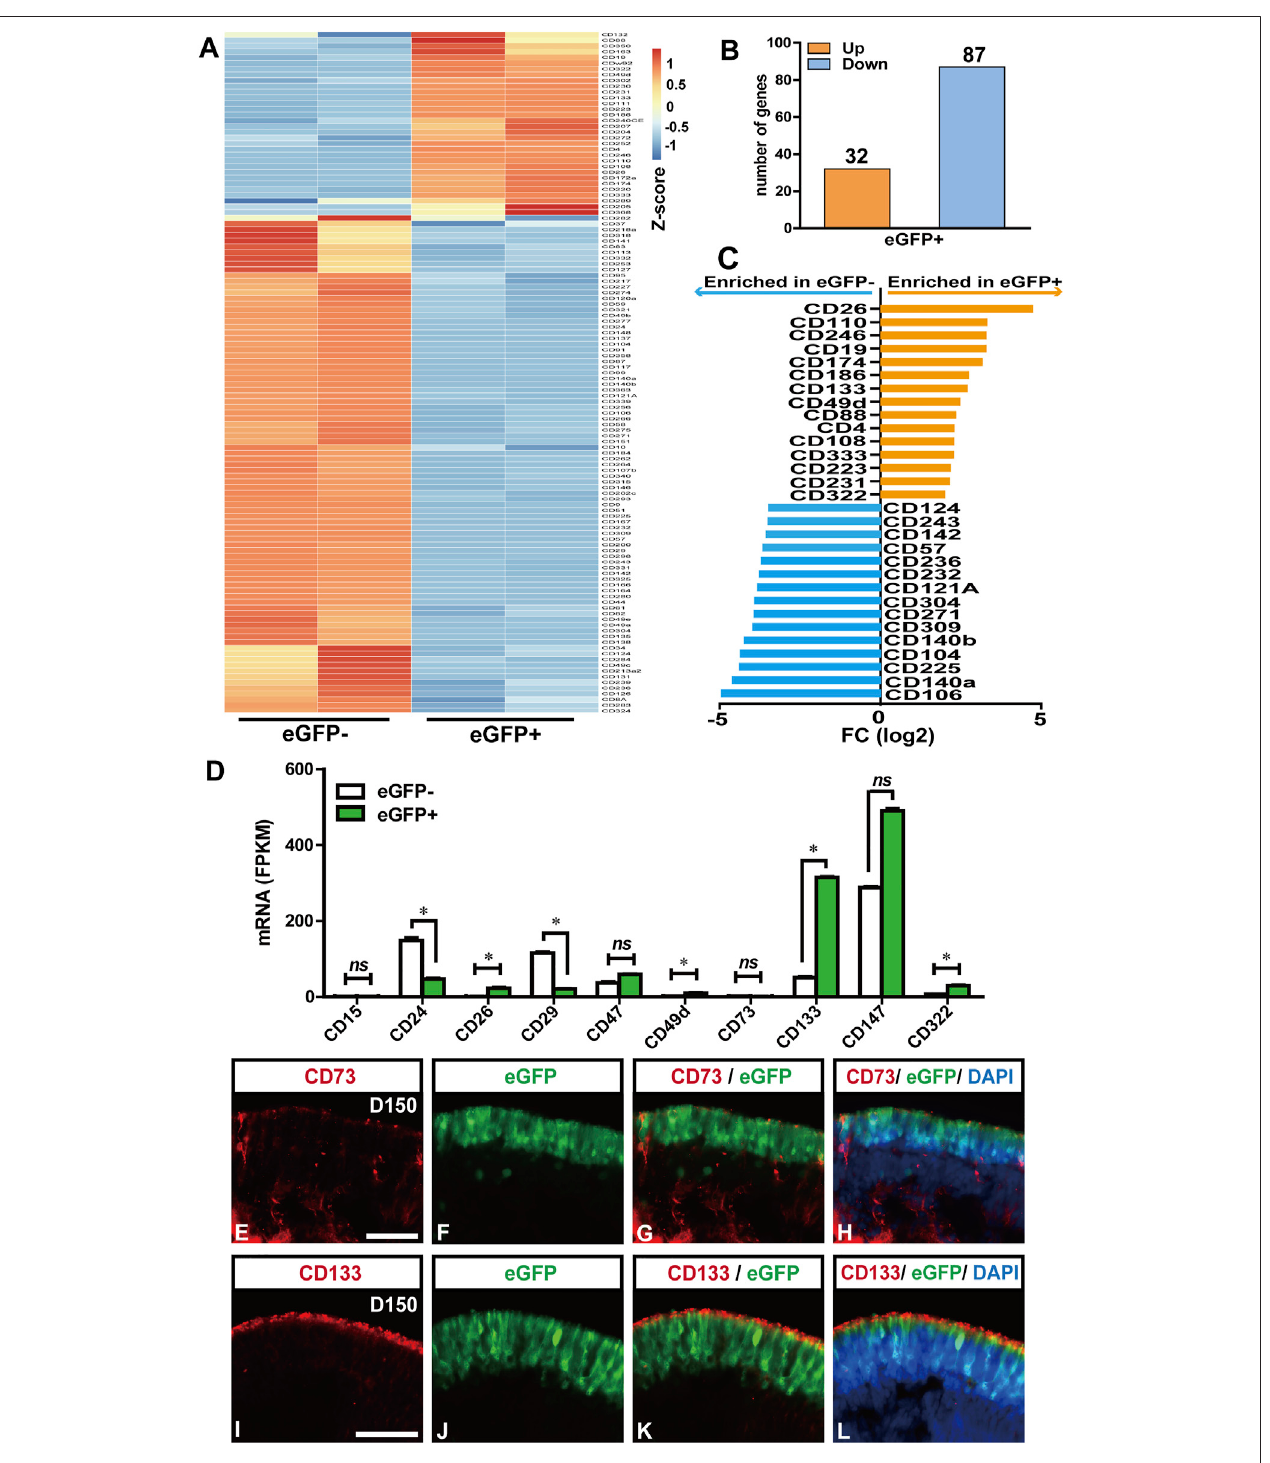
FIGURE 6 | Potential clusters of differentiation (CD) biomarkers for RCVRN-eGFP+ photoreceptors. (A) Heat map showed all the differentially expressed genes (DEGs) of CD biomarkers between eGFP- and eGFP+ cells from D150 retinal organoids. Absolute fold change (FC) > 2 and false discovery rate (FDR) < 0.05 were considered signi fi cant. (B) Bar graph showed the number of upregulated (Up) and downregulated (Down) DEGs in eGFP+ cells, compared with eGFP- cells. (C) Bar graph showed the top 15 DEGs signi fi cantly upregulated with FPKM > 1 in the eGFP+ photoreceptors (orange) and the top 15 DEGs upregulated with FPKM > 1 in eGFP- cells (blue). (D) Bar graph showed the fragment per kilobase of transcript per million mapped reads (FPKM) values of the CD biomarkers reported previously for photoreceptor selection. * p < 0.05; ns, no signi fi cance ( p > 0.05). (E – H) Immuno fl uorescence (IF) images showed CD73 wasweakly and unspeci fi cally expressed in the D150reporterretinalorganoids(ROs). (I – L) IFimagesveri fi edtheCD133wasspeci fi callyexpressedineGFP+photoreceptorsintheD150ROs.Nucleiwerestainedwith DAPI, Scale bars, 50 μ m (E – L).